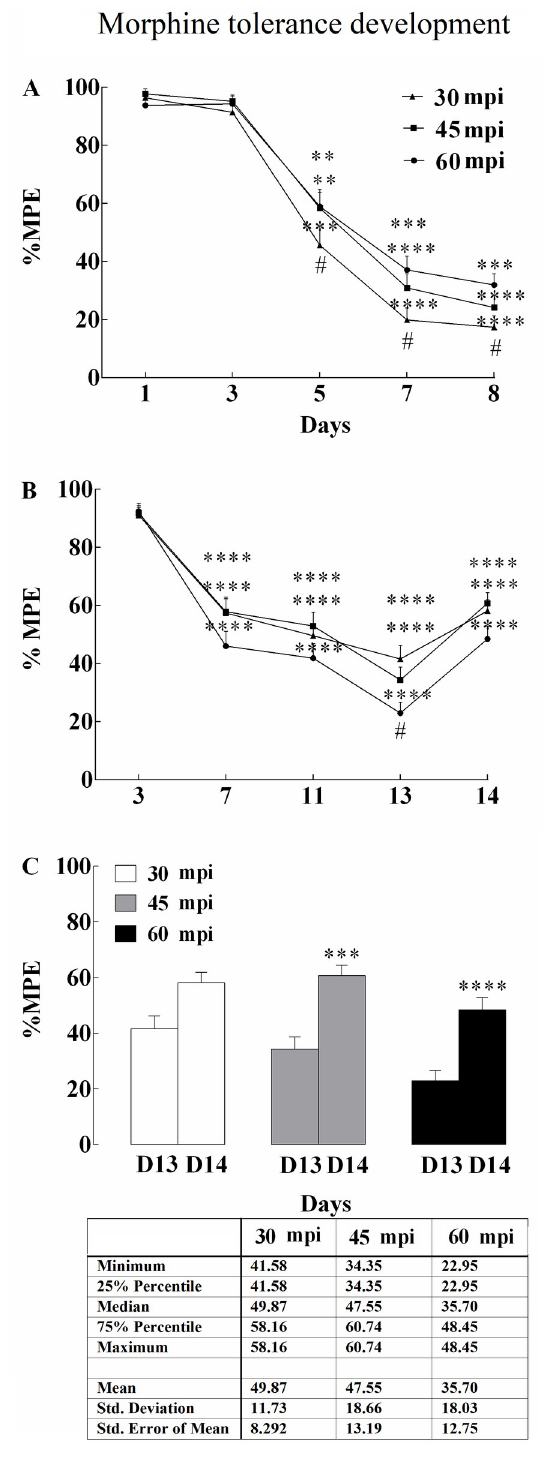
Fig 1. The development of non-associative (NAMT) and associative (AMT) tolerance to the analgesic effects of morphine. (A) For the development of NAMT, morphine (4 mg/kg) was injected S.C. every day for 8 days and % Maximum Possible Effect (%MPE) was measured at 30, 45, and 60 min after the injection. (B) Development of AMT by administrating morphine (4 mg/kg) on odd-numbered days in the morphine-paired environment and saline on even-numbered days in the saline-paired environment. AMT is a context dependent phenomenon. (C) Tail-flick